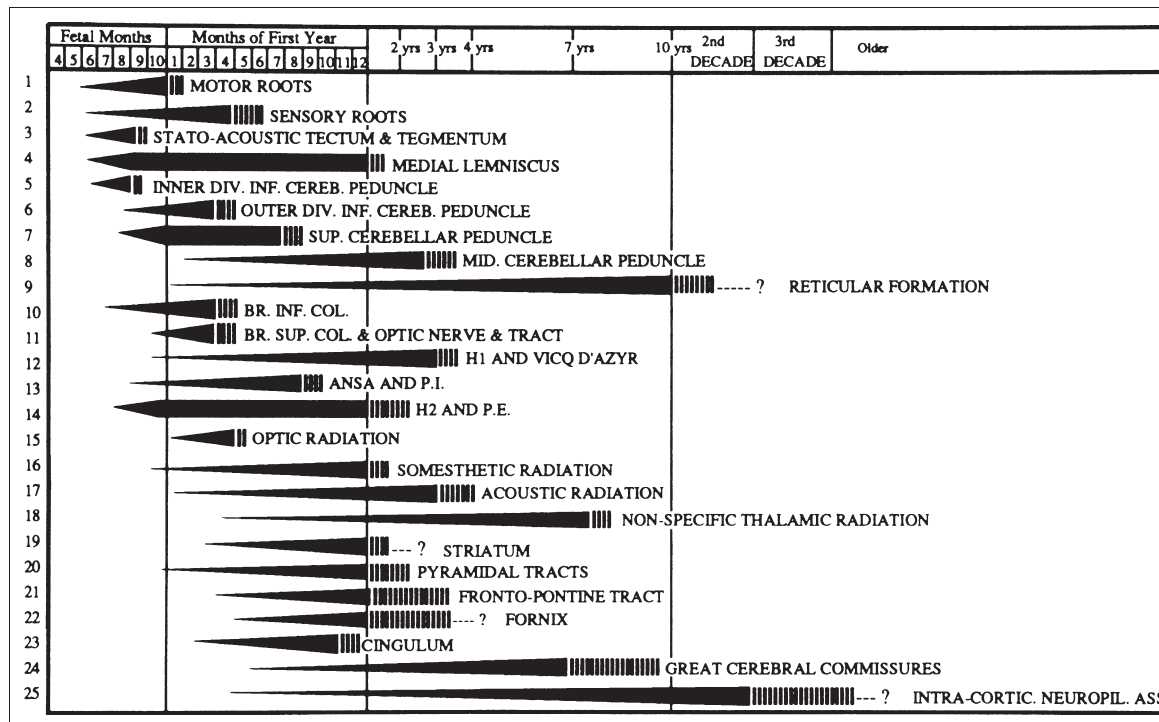
FIGURE 3 | Myelination during brain maturation in the human. From Yakovlev and Lecours (1967), with